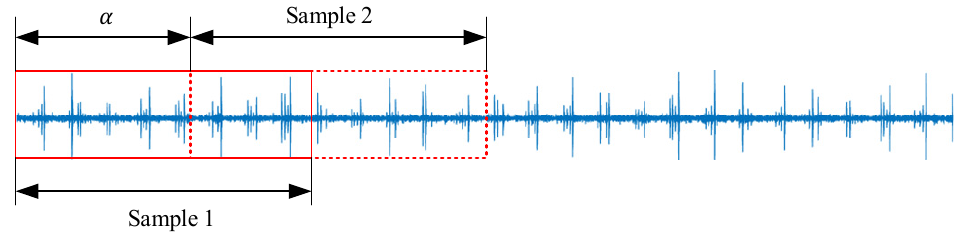
Figure 6. Data enhancement diagram.